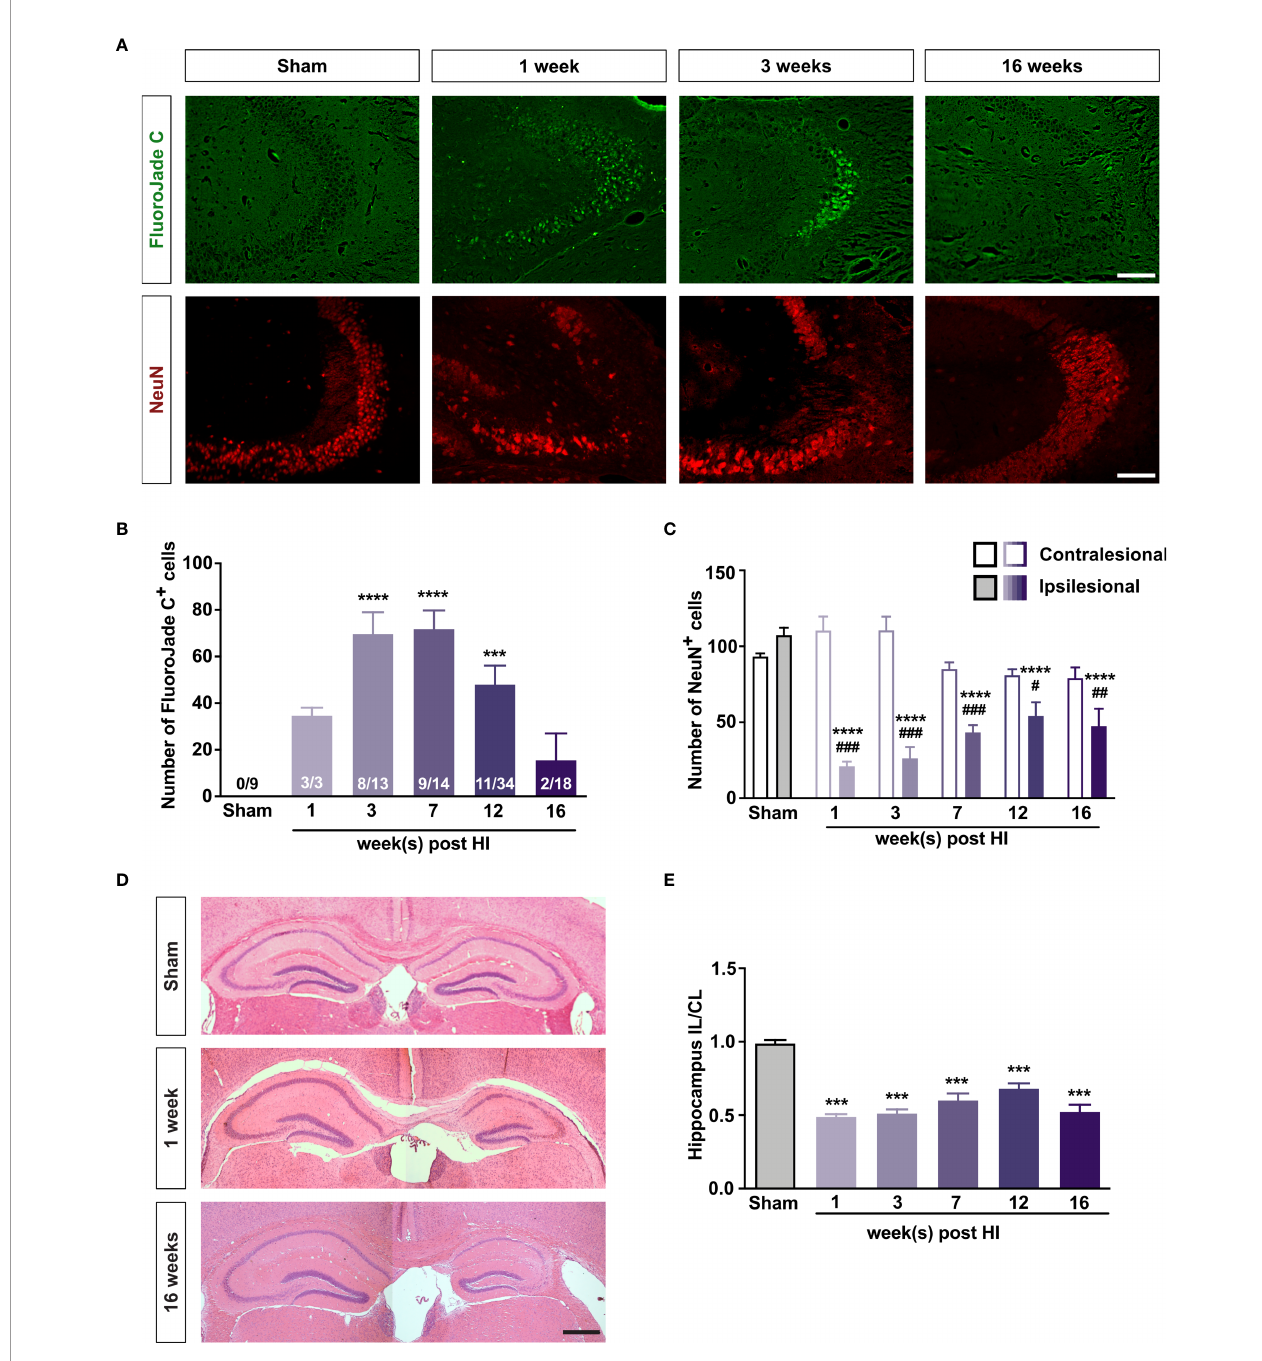
FIGURE 1 | Mild HI injury to developing brain leads to long-lasting neurodegeneration in the ipsilesional hippocampal CA3. (A) Representative images of ipsilesional CA3 in which degenerating neurons are visualized with FJC and all neurons are visualized with antibodies against NeuN 1 – 16 weeks after HI induction or 3 weeks after sham surgery. Scale bar = 50 µm. (B) Number of FJC + cells and (C) number of NeuN + cells in the CA3 of mice 1 – 16 weeks after neonatal HI induction or 3-7 weeks after sham surgery. (D) Representative images of hematoxylin-eosin – stained brain sections of mice 1 and 16 weeks after HI induction or 7 weeks after sham surgery. (E) Relative size of the ipsilesional hippocampus in mice 1 – 16 weeks after neonatal HI induction or 3 – 7 weeks after sham surgery. IL, ipsilesional; CL, contralesional. *** P < 0.001, **** P < 0.0005 vs sham; # P < 0.05, ## P < 0.005, ### P < 0.001 vs contralesional. Data were analyzed by one-way ANOVA and Dunnett ’ s posthoc test (B, E) or two-way ANOVA and Sidak ’ s posthoc test (C) . Numbers in bars are number of positive mice/total number of mice (B) . (C) n = 9 (sham); n = 3, 9, 14, 10, and 10 for 1, 3, 7, 12, and 16 weeks after HI induction, respectively. (E) n = 18 (sham); n = 3, 13, 14, 16, and 18 for 1, 3, 7, 12, and 16 weeks after HI induction, respectively. Values are mean ±